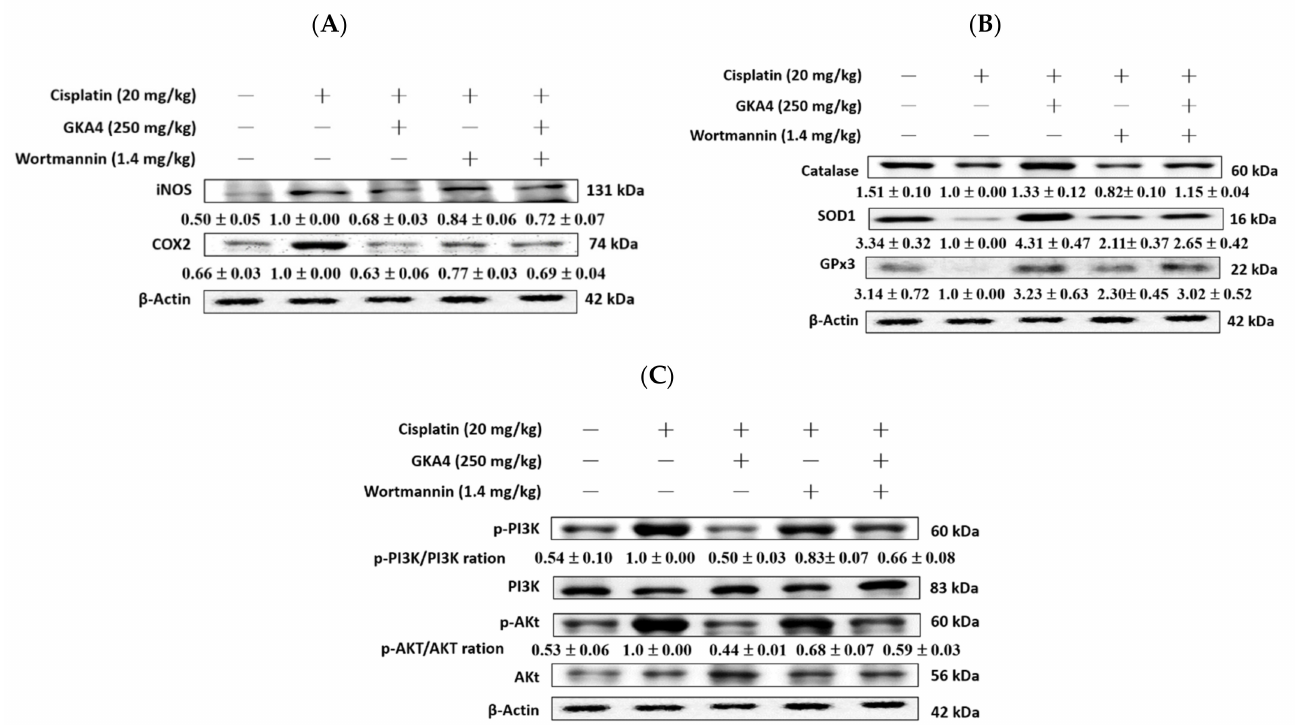
Figure 10. GKA4 and wortmannin-regulated inflammatory ( A ), oxidative stress ( B ), and PI3K/AKT signal-related proteins ( C ) after cisplatin-challenged AKI. Kidney tissue lysate was subjected to western blot analysis using specific antibodies for iNOS, COX-2, catalase, SOD1, GPx3, p-PI3K, PI3K, p-AKT, and AKT. Protein bands were analyzed by densitometric analysis. Experiments were repeated at least three times, and the representative images are shown. Plus signs: with drug; Minus signs: without